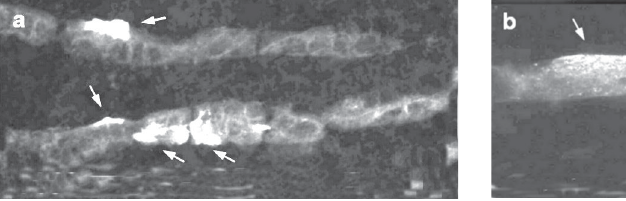
Figure 5. Nicotinic acetylcholine receptor (nAChR) clusters ex- pressed in ectopic muscle and in the extensor digitorum longus (EDL) endplate from adult male rats. Tissue sections from 7-day (a,b) or 14-day (c,d) ectopic skel- etal muscle fibers were labeled with tetramethylrhodamine-la- beled α -bungarotoxin and the distribution of nAChRs was